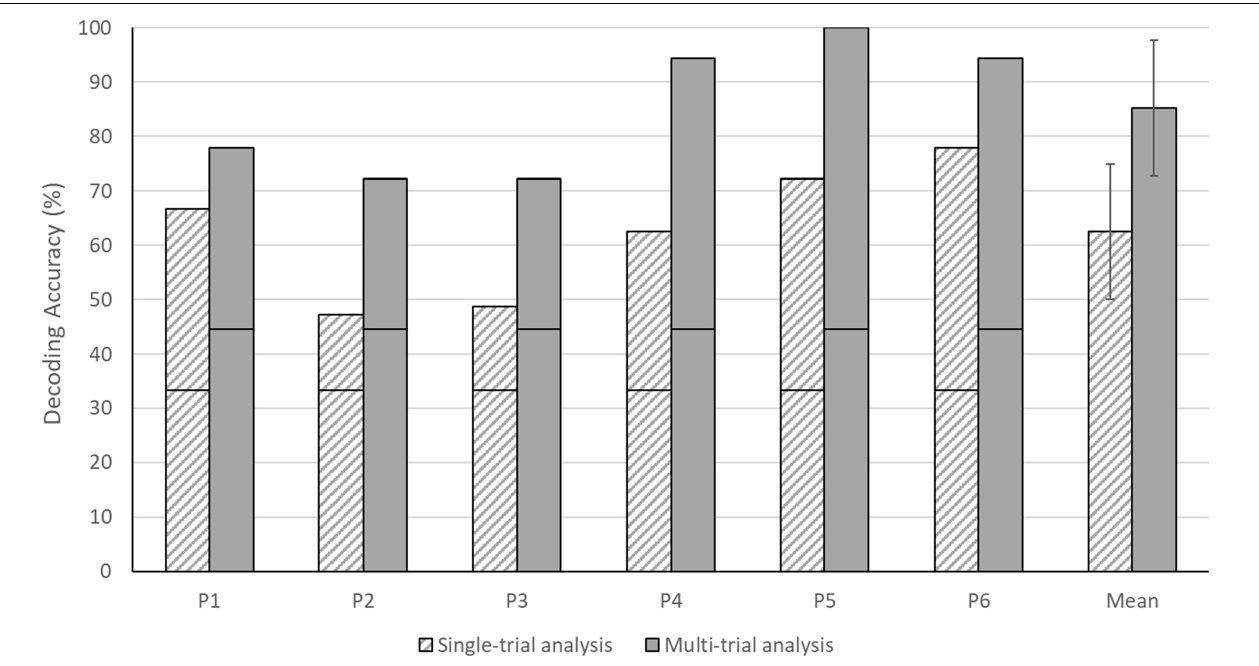
FIGURE 5 | Single- and multi-trial answer decoding accuracies for individual participants and the group. The black horizontal stripe within each bar graph represents the chance level for single-trial (33.33%) and multi-trial (44.44%) accuracies. The error bars depict the standard deviation of the group mean. Note that all participants performed above the chance level in both